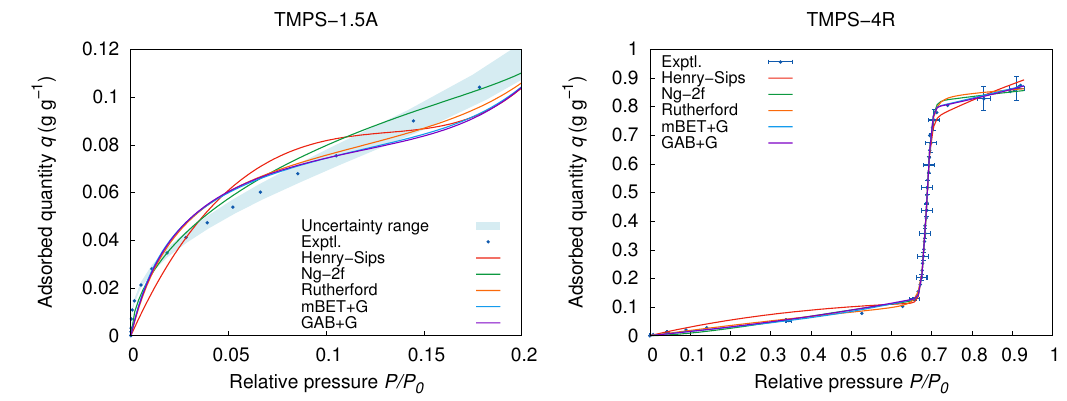
Figure 6. Detailed view on the models fitting at low P / P 0 for TMPS-1.5A and full view for TMPS-4R at 25 ◦